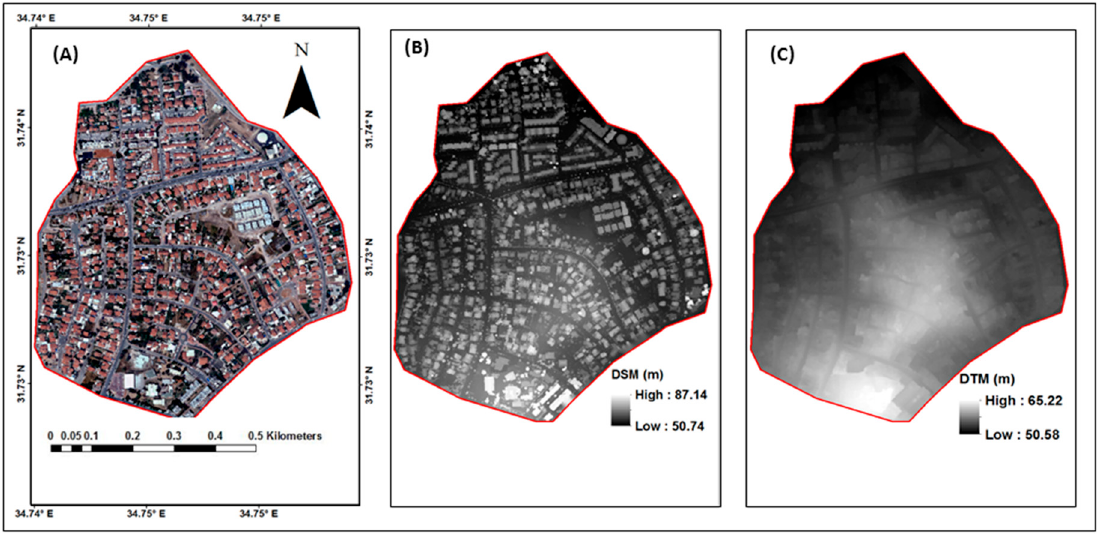
Figure 2. ( A ) A true-color orthophoto image of the study area, ( B ) digital surface model (DSM), ( C ) digital terrain model (DTM).